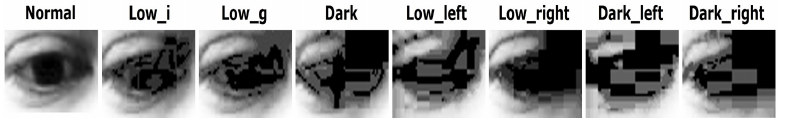
Figure 6. Binary images of low and dark illuminated test sets.